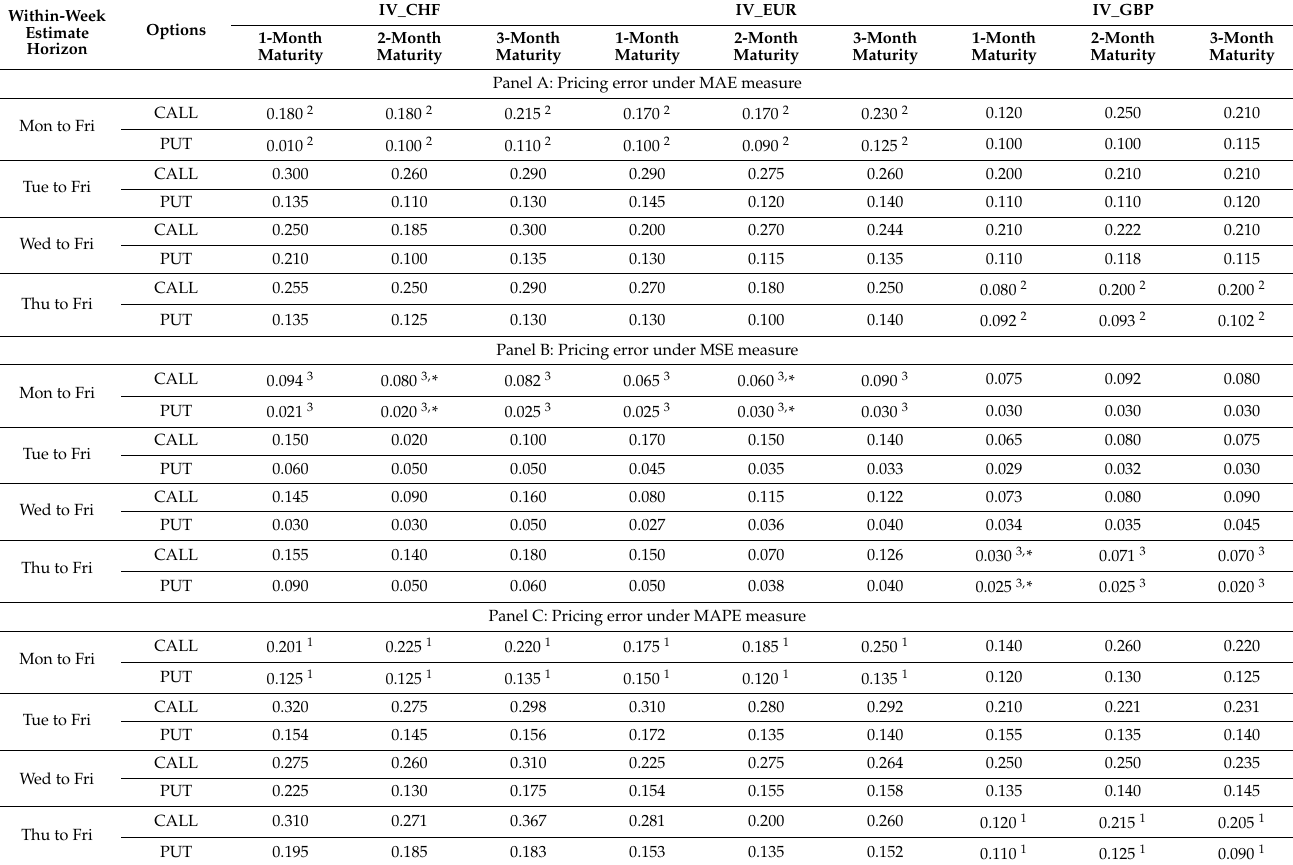
Table 4. Estimate options pricing error for the within-week horizon.